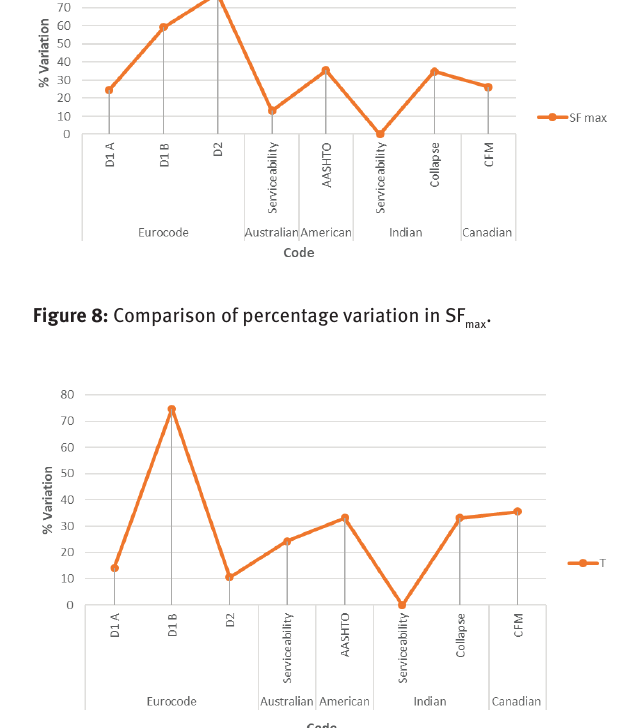
Fig. 9 Comparison of percentage variation in